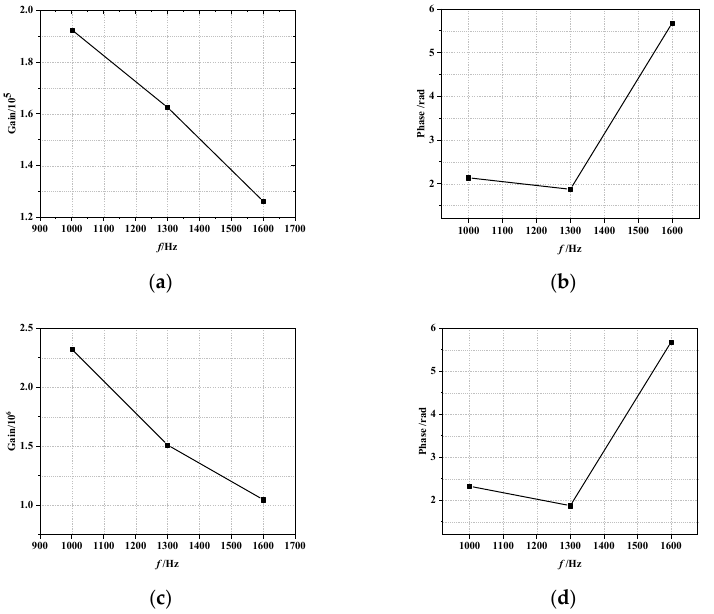
Figure 11. The flame transfer function of the central injector. ( a ) The amplitude–frequency curve of Scheme 7. ( b ) The phase-frequency curve of the Scheme 7. ( c ) The amplitude–frequency curve of Scheme 8. ( d ) The phase–frequency curve of the Scheme 8. Table 8. Frequency and stability of the first-order longitudinal, zero-order tangential, zero-order radial modes for Scheme 1, 7, and 8.